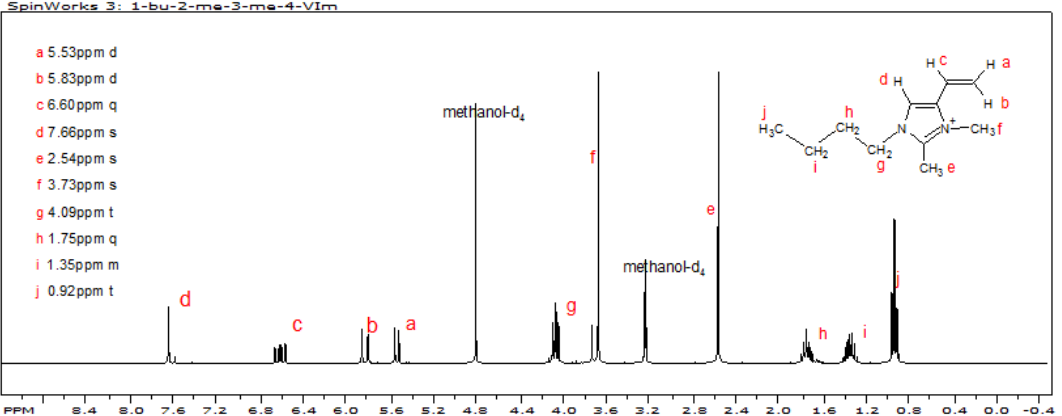
Figure 5. 1 H NMR spectrum of 1-butyl-2,3-dimethyl-4-vinylimidazolium triflate . Figure 5. 1 H nmR spectrum of 1-butyl-2,3-dimethyl-4-vinylimidazolium